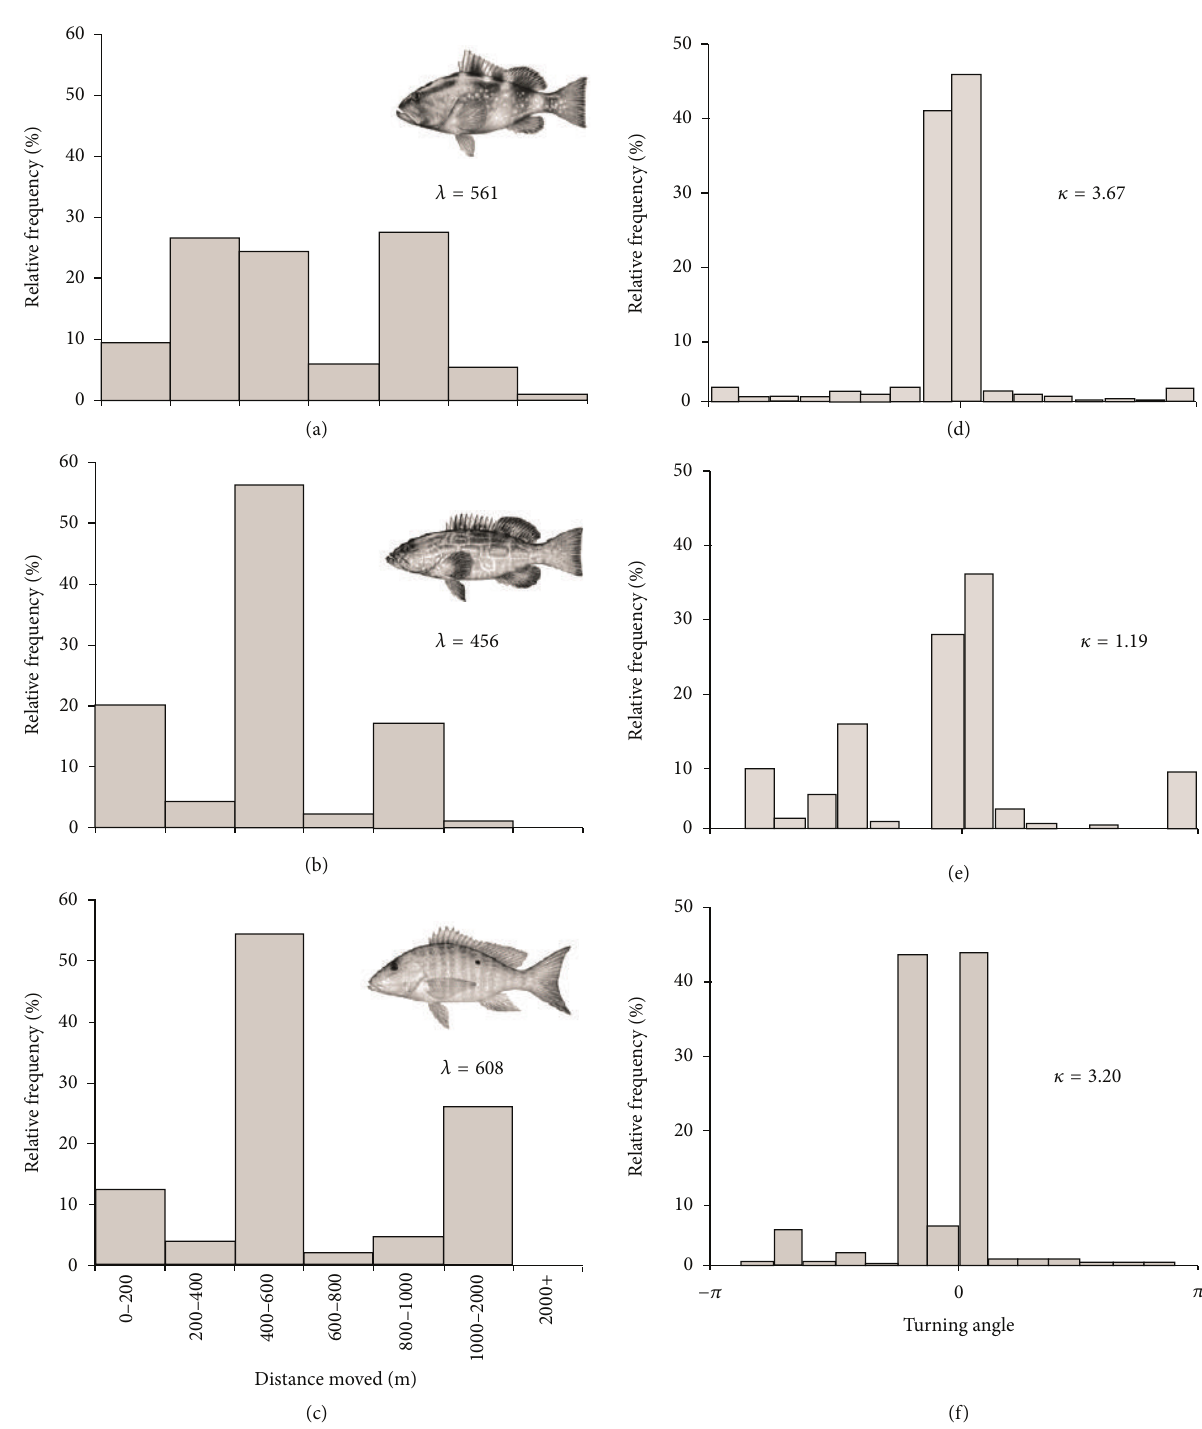
Figure 1: Relative frequency histograms of observed (a)–(c) nonzero movements and (d)–(f) turning angles relative to home range center for ((a), (f)) all tracked red grouper ( Epinephelus morio ), ((b), (e)) black grouper ( Mycteroperca bonaci ), and ((c), (f)) mutton snapper ( Lutjanus analis ). Means ( 𝜆 ) of exponential distribution of movement distance and concentration parameter ( 𝜅 ) of von Mises distribution of turning angles are provided on figures. Fish illustrations copyright Diane Rome